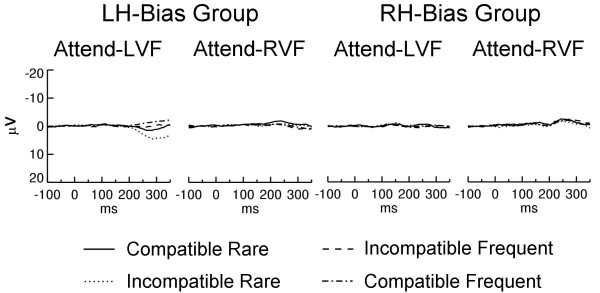
Horizontal EOG data. Grand average horizontal EOG data in each condition for the hemispheric utilization bias groups are shown. Note that stimulus offset was at 150 ms. In the recording procedures used, 1° of visual angle was equal to approximately +/- 20 μV EOG amplitude.